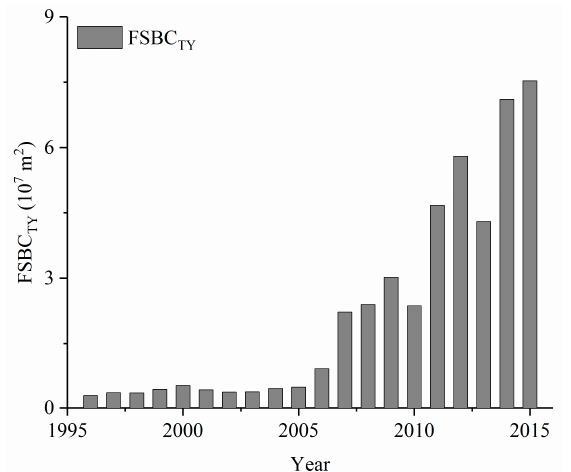
Figure 8. Temporal variation in the annual floor space data for buildings under construction in Taiyuan city (FSBC TY ) values from 1996 to 2015.